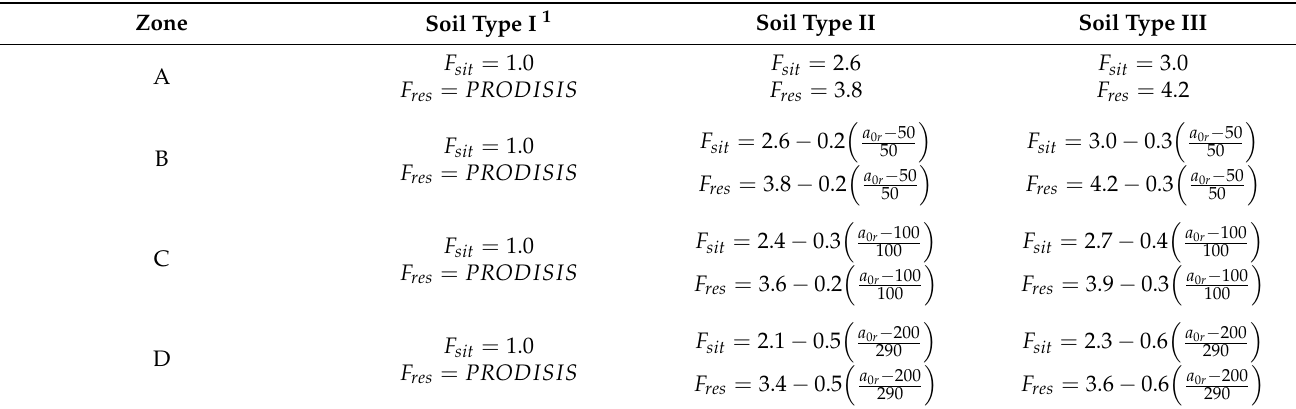
Table 6. F sit and F res factors for dynamic amplification factors at the site, reproduced with permission from Ulises Mena, Comisi ó n Federal de Electricidad Manual de Diseño de Obras Civiles; published by Comision Federal de Electricidad (CFE), 2015 [1].